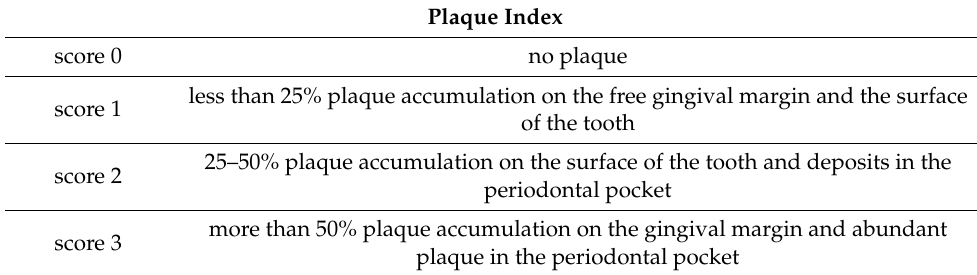
Table 1. Clinical parameter.